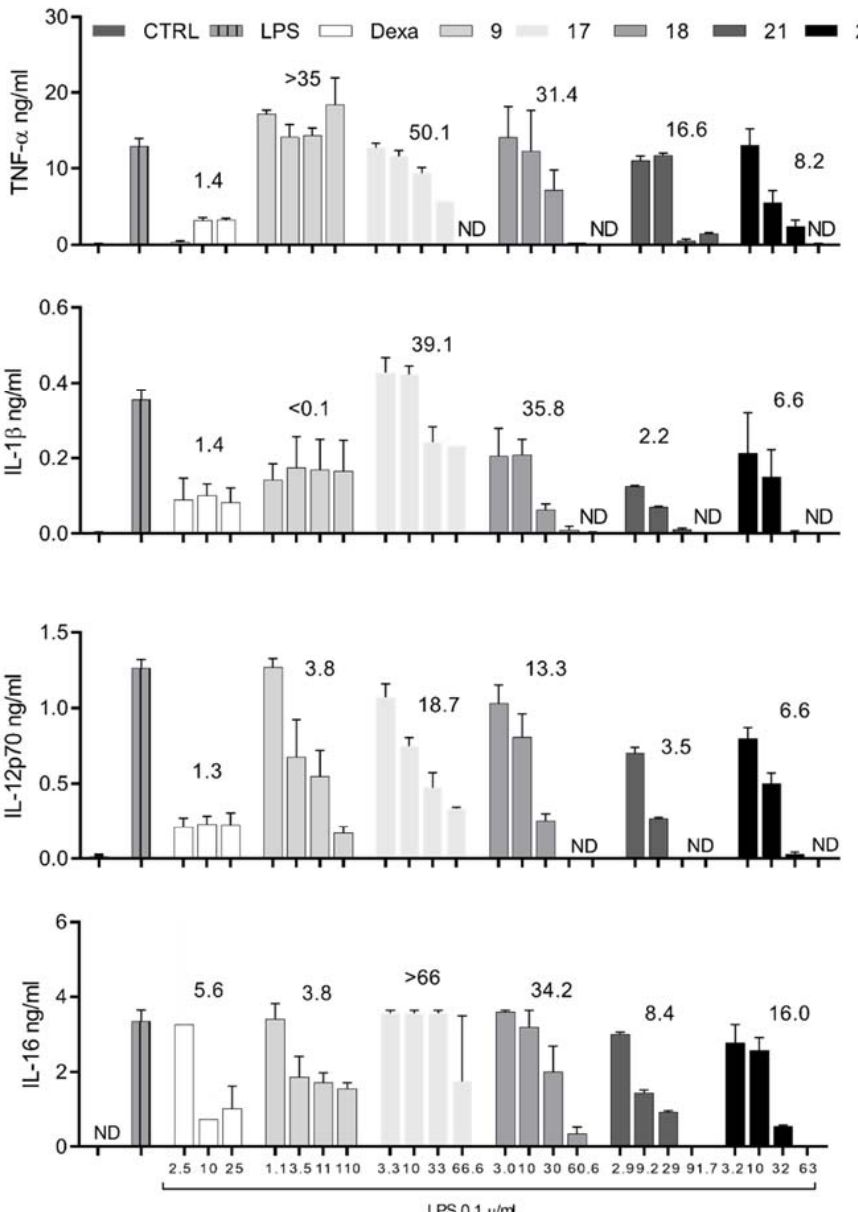
Figure 2. Dose-dependent inhibition of pro-inflammatory cytokine production in DCs by selected semisynthetic abietane diterpenoids. Dendritic cells were generated and treated with the indicated concentration of DHA derivatives 9 , 17 and 18 and TQs 21 and 23 and subsequently stimulated with LPS and the concentration of cytokines released to supernatants was determined by ELISA assay (see Methodology for details). Dexa was used as a positive control whereas vehicle-treated LPS-stimulated DCs were used as negative control. A control with untreated DCs is also shown. Results are reported as the mean ± SEM of two independent experiments. Numbers above each bars group stands for IC 50 values. ND Non